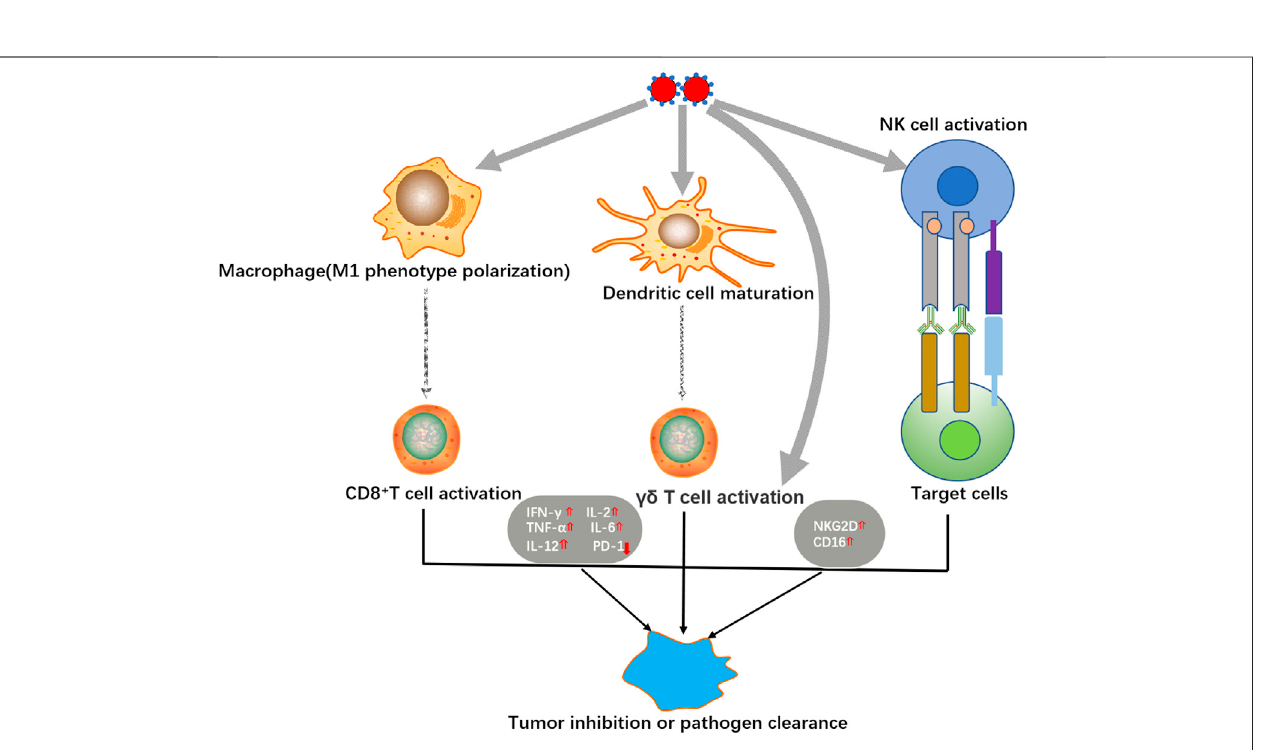
Frontiers in Pharmacology |